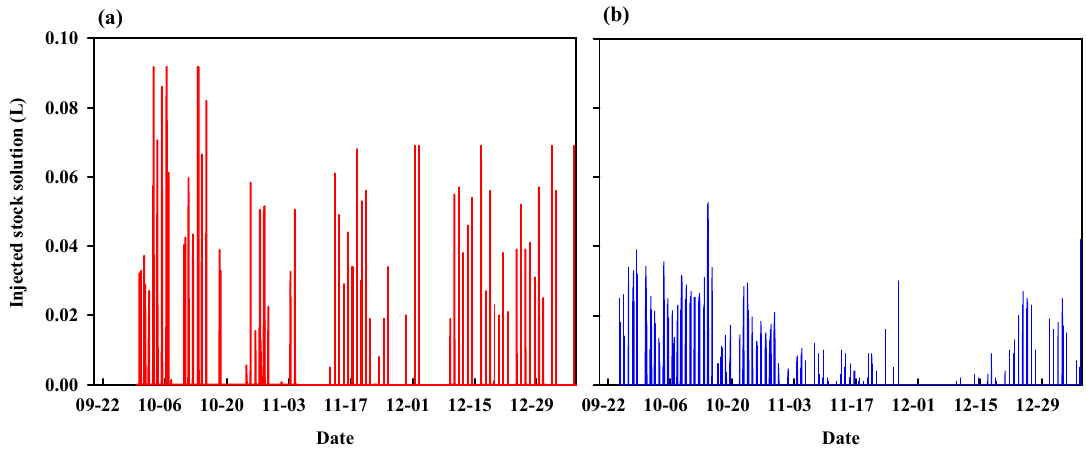
Figure 7. Changes in volume of injected stock solution with conventional (CM, a ) and alternative (AM, b ) nutrient-replenishment methods.